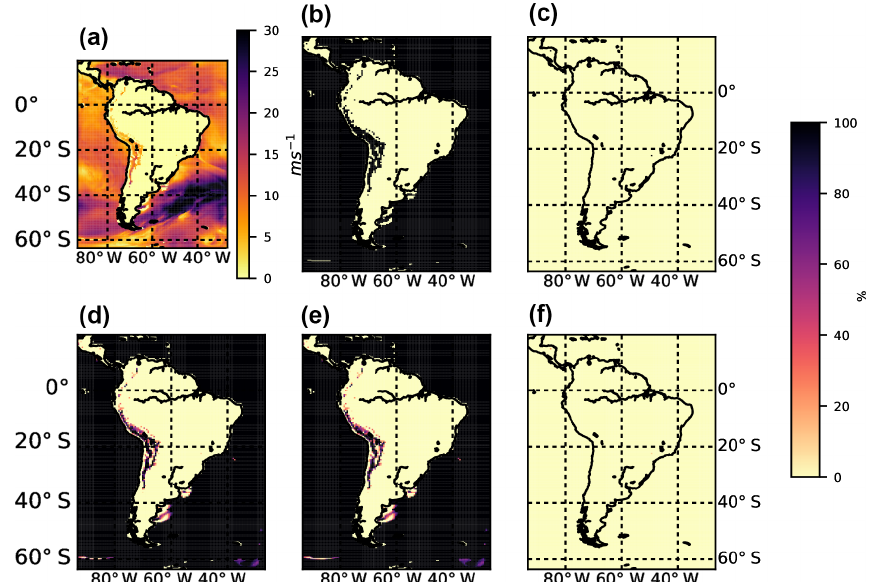
Figure 5. Near-surface wind-gust estimates on 9 December 2012 at 15:00UTC. 3h maximum total wind-gust strength (wsgsmax tot , a ), percentage of wsgsmax tot following the Brasseur method (wsgsmax b01 , b ), percentage following the AFWA heavy precipitation implemen- tation (wsgsmax hp , c ), percentage of time steps for which a grid point got a total wind gust (d) , percentage of time steps for which a grid